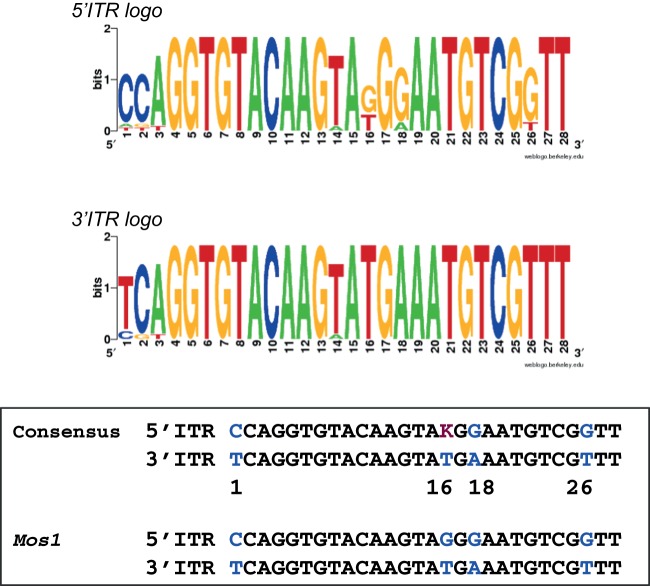
ITR sequence analyses.Sequences of the Mos1-tribe ITRs (Tables 1 and 2) were aligned to obtain 5′ and 3′ITRs logos and consensus. The majority rule was used to define variable positions, which are 1, 2, 3, 14, 18, and 26 in the 5′ITR and 1, 2, 3, and 14 in the 3′ITR. Doing so, the 24 conserved positions in Mos1 ITRs are conserved in the consensus ITRs (black letters). When compared to each other, 5′ and 3′ consensus ITRs contain three clear differences at positions 1, 18, and 26, which are the same as that found in Mos1 ITRs (blue letters). Position 16 (purple letter) in the 5′ consensus remains ambiguous, being either a G (as in the 5′ Mos1 ITR) or a T (as in the 3′ Mos1 ITR).